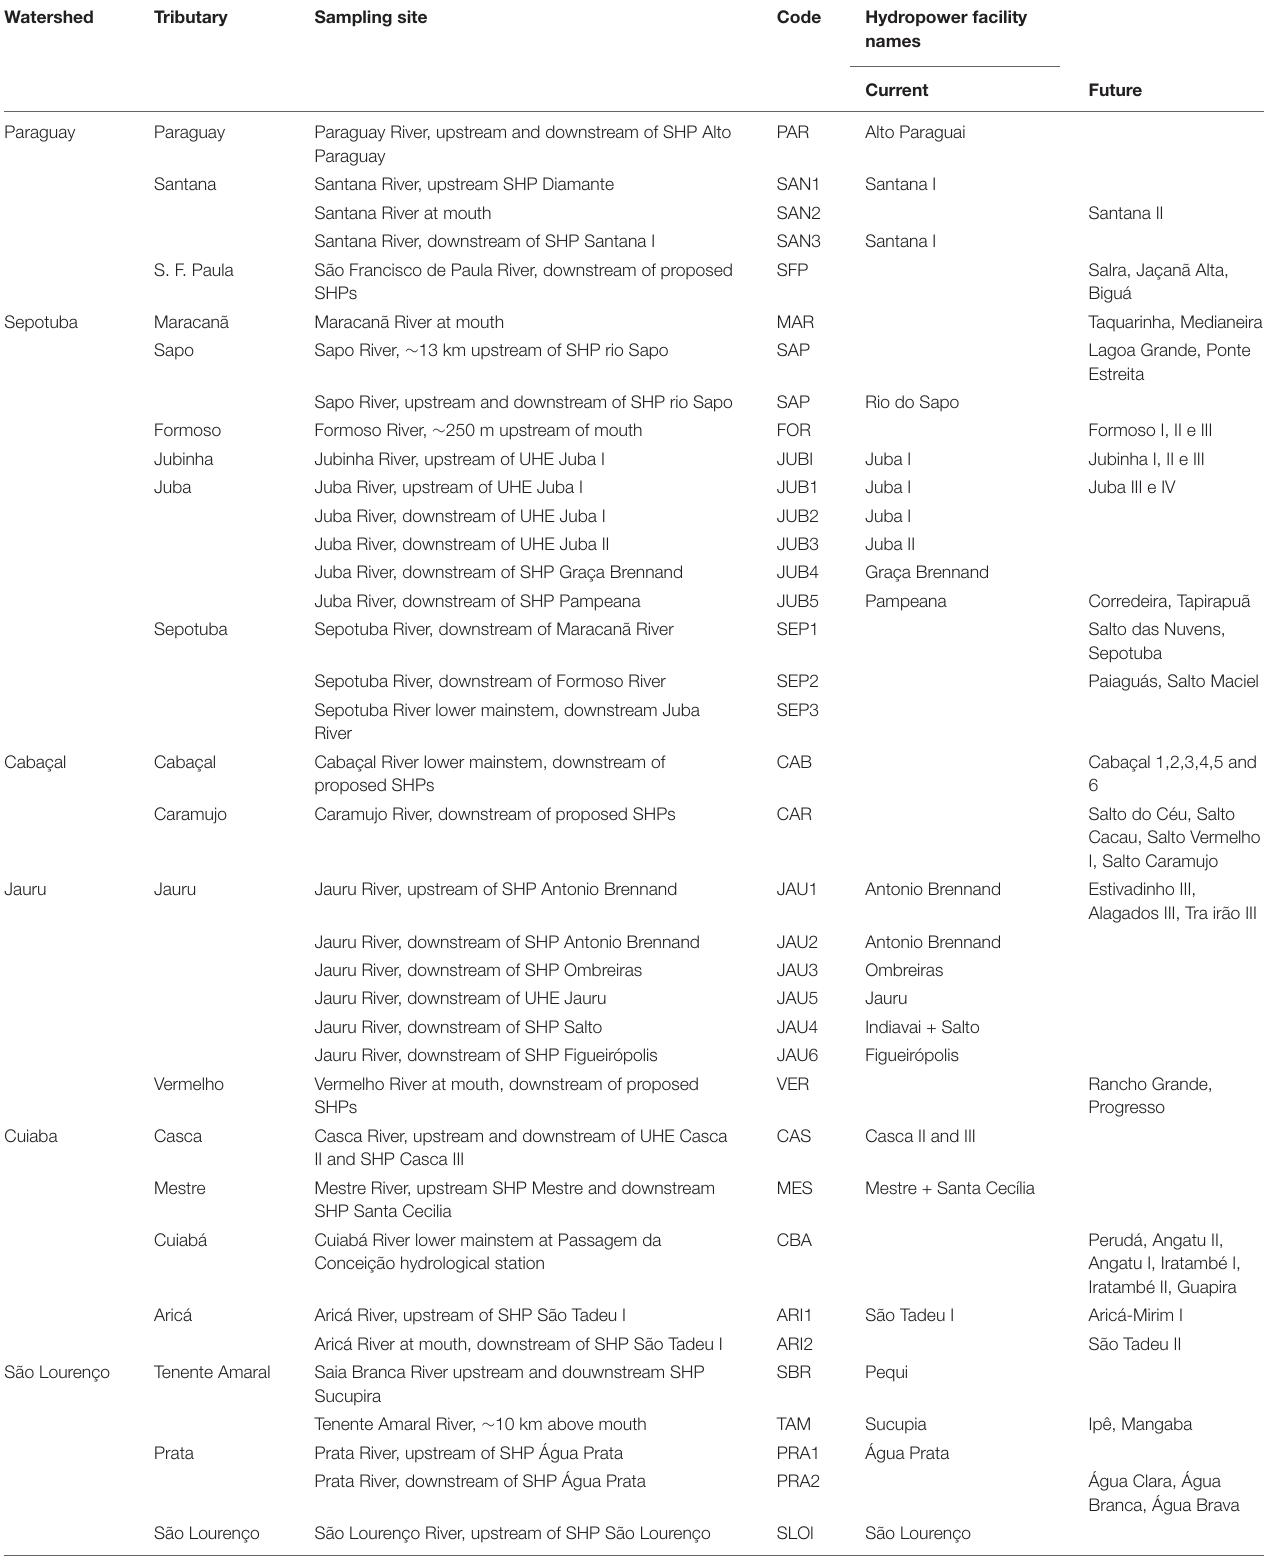
TABLE 1 | List of sampling sites and hydropower facilities they pertain to, with codes for figures and tables.